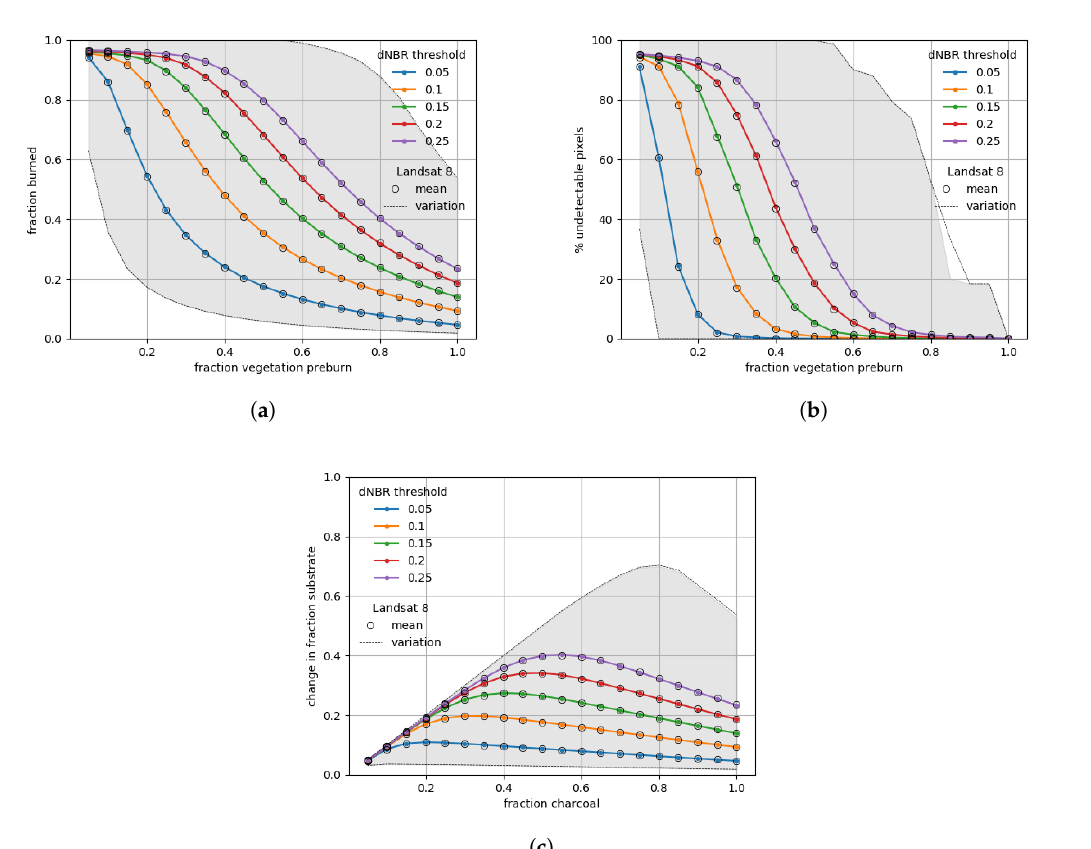
Figure A7. Park-wide detectability results for a pure burn scenario (where loss of vegetation fraction results in equal increase in charcoal fraction ( ∆ char = 1), Sentinel-2B. The mean values are shown in colored lines, with total model result variation shown in gray. To compare, the results for Landsat 8 are shown in black, with mean values shown by circles and total model result variation shown by dashed lines. ( a ) Fraction of vegetation burned at detection. ( b ) Percentage of undetectable pixels. ( c ) Charcoal contribution on